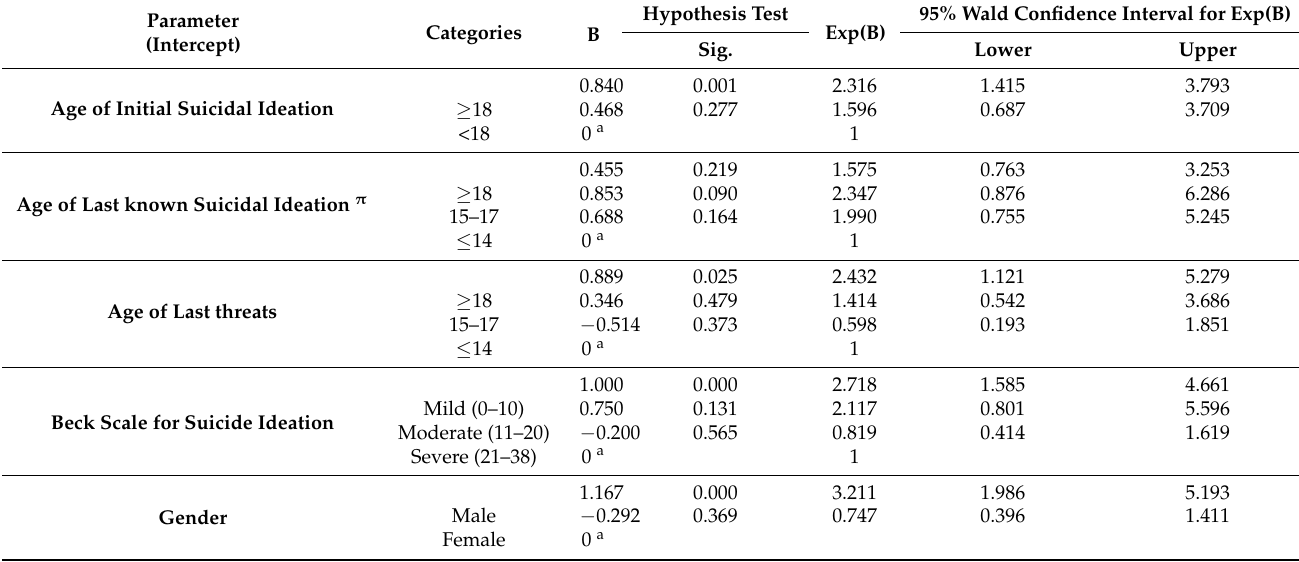
Table 4. Multivariate Analysis (GLM)* of Actual Clinical Severity of the Soldiers’ Most Recent Suicide Attempt (N = 65). Parameter